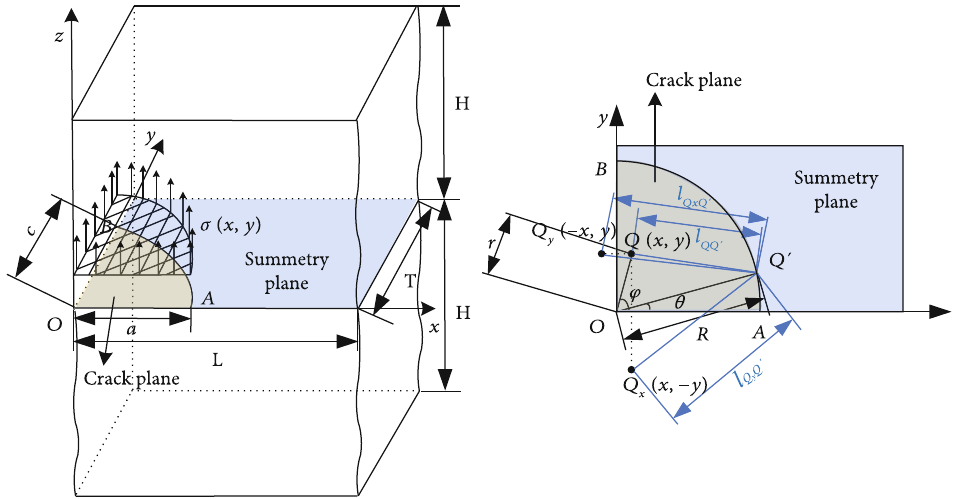
Figure 1: Geometry and coordinate